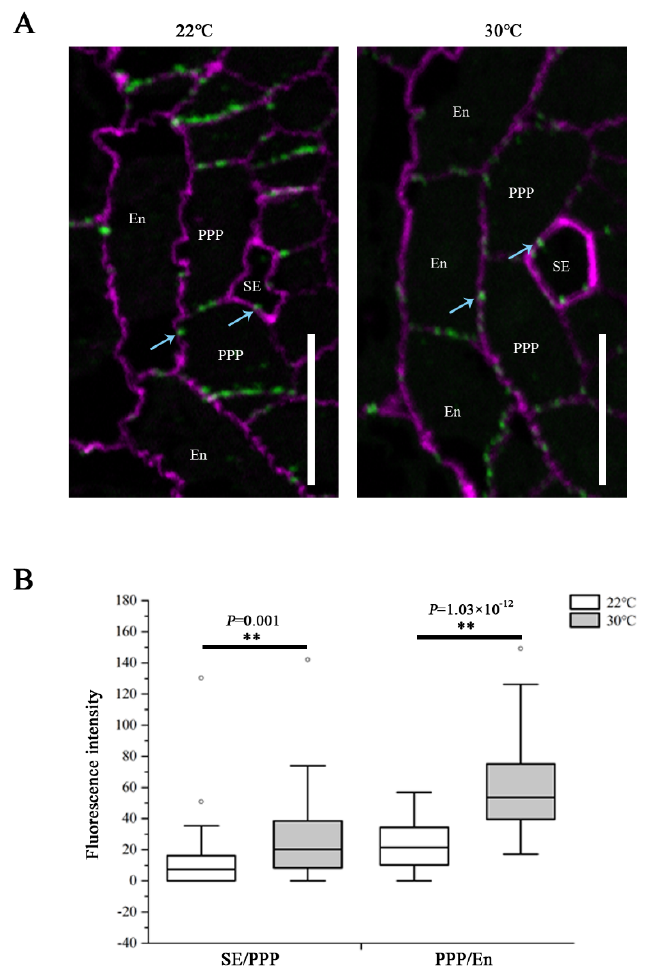
Figure 3. Heat stress induces callose deposition at SE–PPP and PPP–endodermal interfaces within the unloading zone. ( A ) Immunolocalization of callose at plasmodesmata (blue arrows) at the SE–PPP and PPP–endodermis interfaces in the same region of the unloading domain (200 μ m upward of QC) in the root tips of Col-0 at 24 h after transferred to 22 °C and 30 °C. Scale bars = 10 μ m. ( B ) Mean fluorescence intensity of the callose signals are calculated in ImageJ. In the box plots, the boxes indicate the first and third quartiles, and the whiskers indicate the minimum and maximum values. The black lines within the boxes indicate the median values. Outliers are shown as dots. ** p < 0.01 (two-tailed, two-sample t -test).